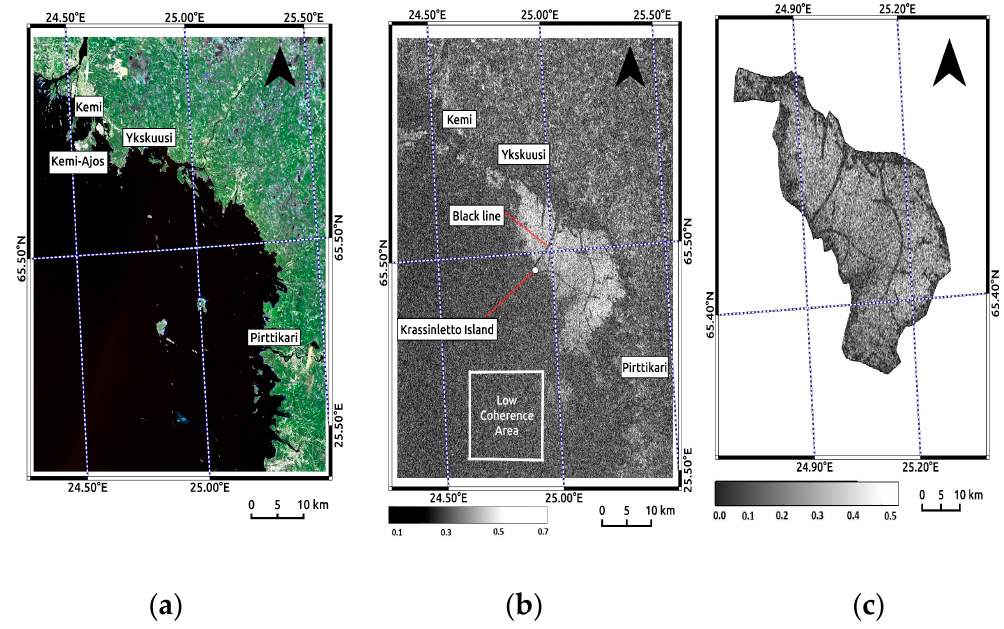
Figure 7. The degree of interferometric coherence for image pair on 6 and 18 February 2015 over the study area: ( a ) Sentinel-2 image showing an optical overview of the study area on 29 May 2015, where green areas are land and islands, and black areas are water; ( b ) interferometric coherence magnitude image; and ( c ) a polygon extracted from the InSAR coherence image, variation of coherence is 0.2–0.46